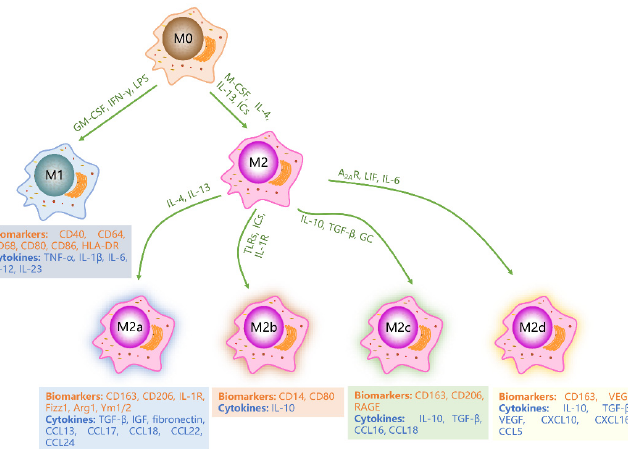
Figure 2. Schematic diagram of macrophage subtypes. Under stimulation by GM-CSF, IFN- γ , and LPS, M0 macrophages polarize into M1 macrophages. Alternatively, M-CSF, IL-4, IL-13, and IC stimulation lead to polarization of M0 macrophages into M2 macrophages. Various cytokines further induce M2 macrophages to differentiate into M2a, M2b, M2c, and M2d phenotypes. M1, M2a, M2b, M2c and M2d macrophages express distinct biomarkers and secrete diverse cytokines. Green letters represent cytokines or factors that promote macrophage polarization. Orange letters represent biomarkers of macrophages. Blue letters indicate cytokines secreted by macrophages.